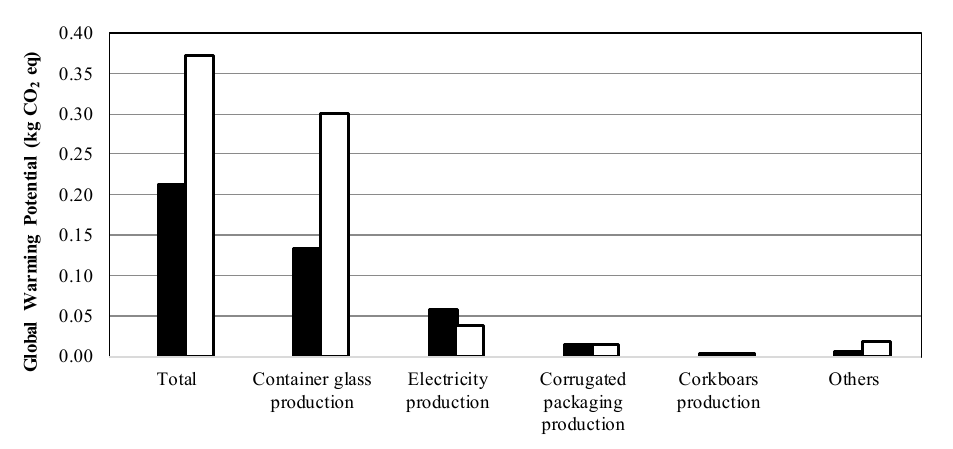
Figure 16. Global warming potential values for the winery. Note: case study I (closed bars) and case study II (open bars) for the year 2017.